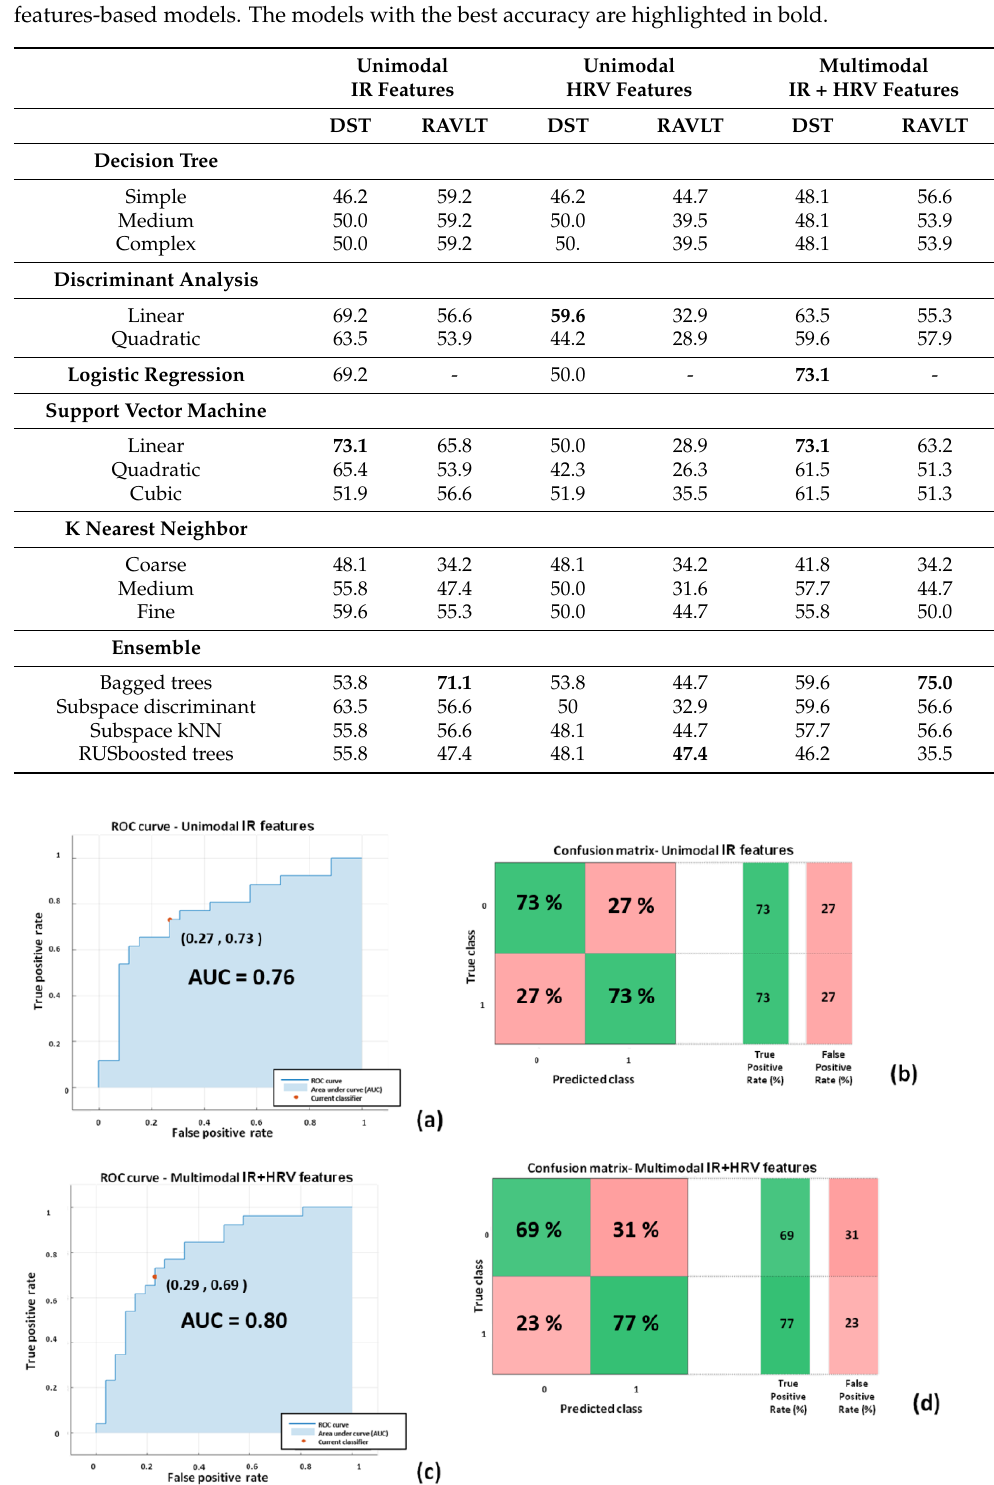
Figure 13. Performances of the SVM classifiers for DST: ( a ) ROC curve for unimodal IR features-based classifier; ( b ) confusion matrix unimodal IR features-based classifier; ( c ) ROC curve for multimodal IR + HRV features-based classifier; ( d ) confusion matrix multimodal IR + HRV features-based classifier.